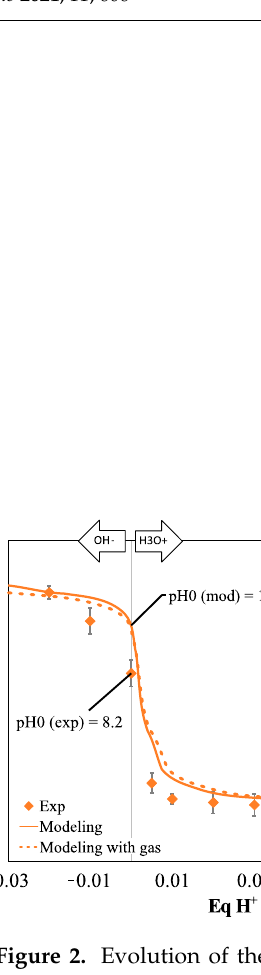
Table 3. Performance measurement of the different modeling results.